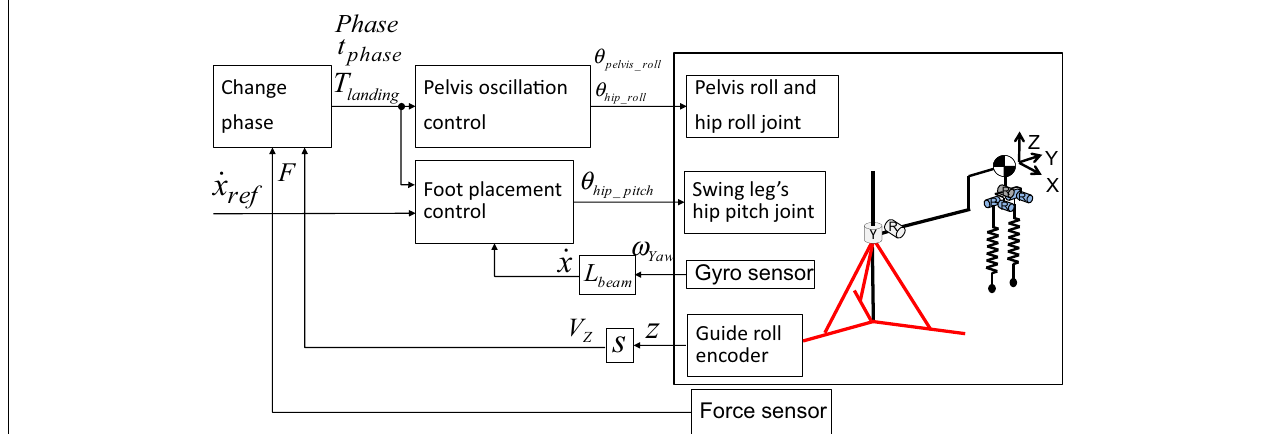
FIGURE 5 | Block diagram of running control . We implemented a pelvic oscillation controller for attaining jumping power and a foot placement controller for controlling the running speed.